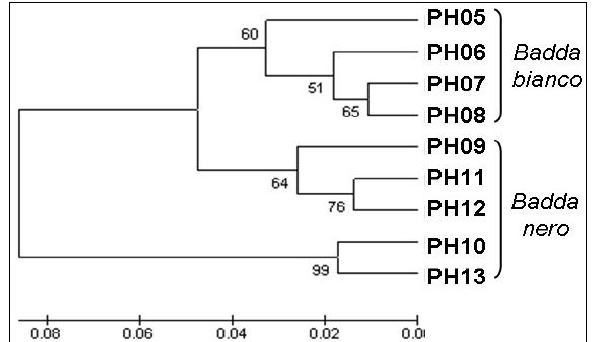
Figure 3. Dendrogram based on Nei’s genetic distances as defined by SSR markers showing the genetic relationships among the “Badda” bean accessions. Support values are